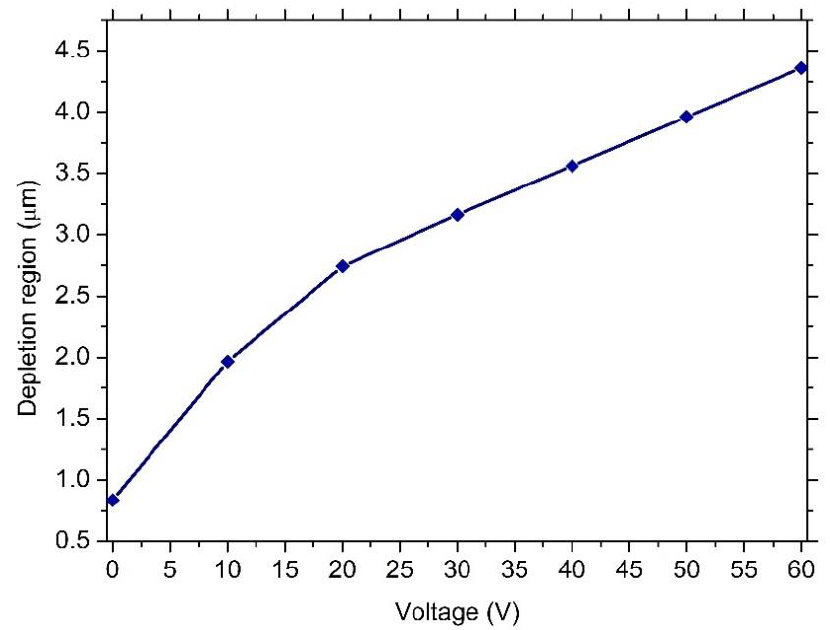
Figure 8. Simulated depletion region width under an optical beam at the responsivity peak wavelength as a function of the applied voltage.